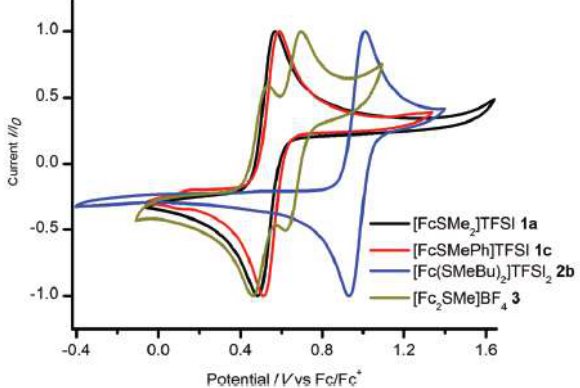
Figure 17. Cyclic voltammograms of selected new ferrocenyl sulfonium compounds plotted against Fc / Fc + . The measurements were performed in [emim][NTf 2 ] with an Ag / Ag NTf 2 reference electrode. Reproduced with permission from [75], copyright 2018, RSC.